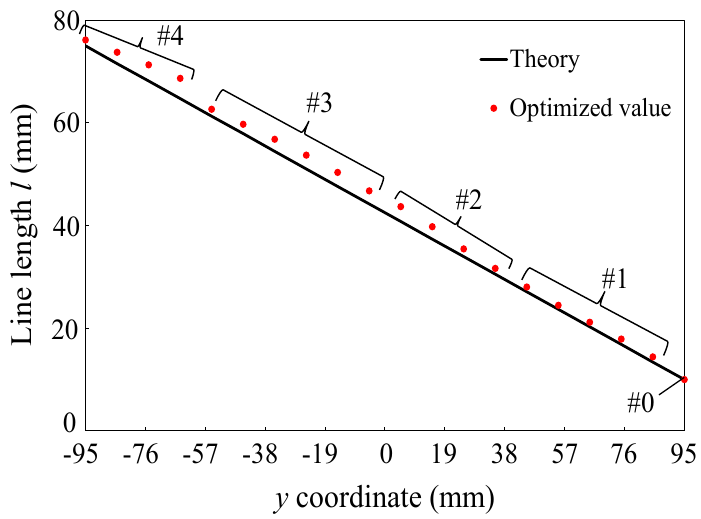
Figure 3. Calculated results of the waveguide length for refracting normal incident plane waves. The solid line is the theoretical value, and the dots are the optimized values. The horizontal axis corresponds to the y coordinate in Figure 1. The refracted angle and the aperture size are chosen as θ = 20 degrees, a = 20 ∆ d = 200 mm, respectively. The values of #1–#4 are used for the structures of #1–#4 in Figure 2. The value at y = 95 mm (#0) can be realized by a 1D straight acoustic waveguide structure ( w = 0.8 mm and l = ∆ d = 10 mm).